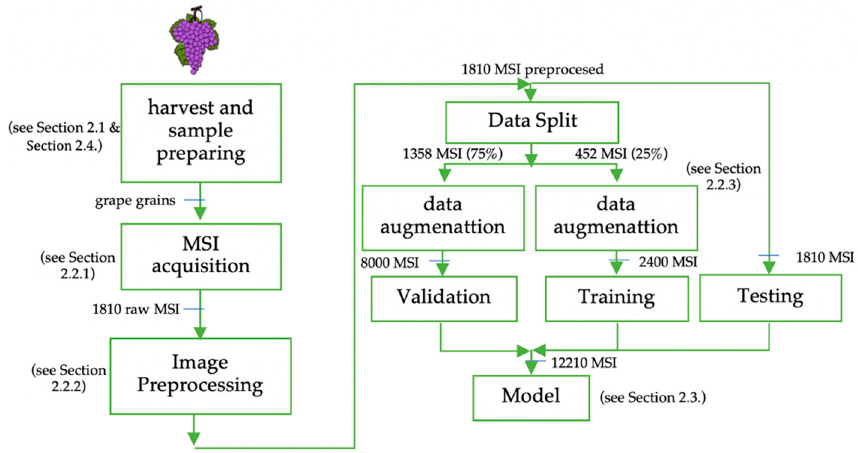
Figure 1. Flow diagram for the acquisition and data augmentation processes.